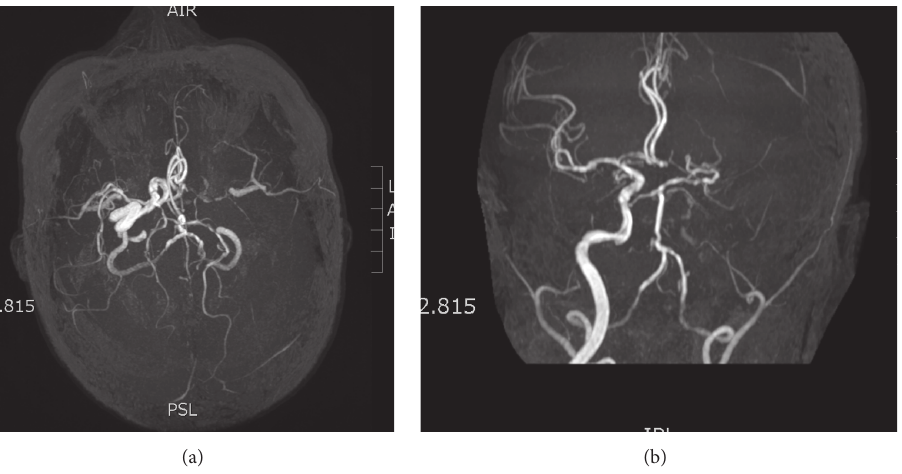
Figure 1: Magnetic resonance angiography showing markedly reduced flow in the left